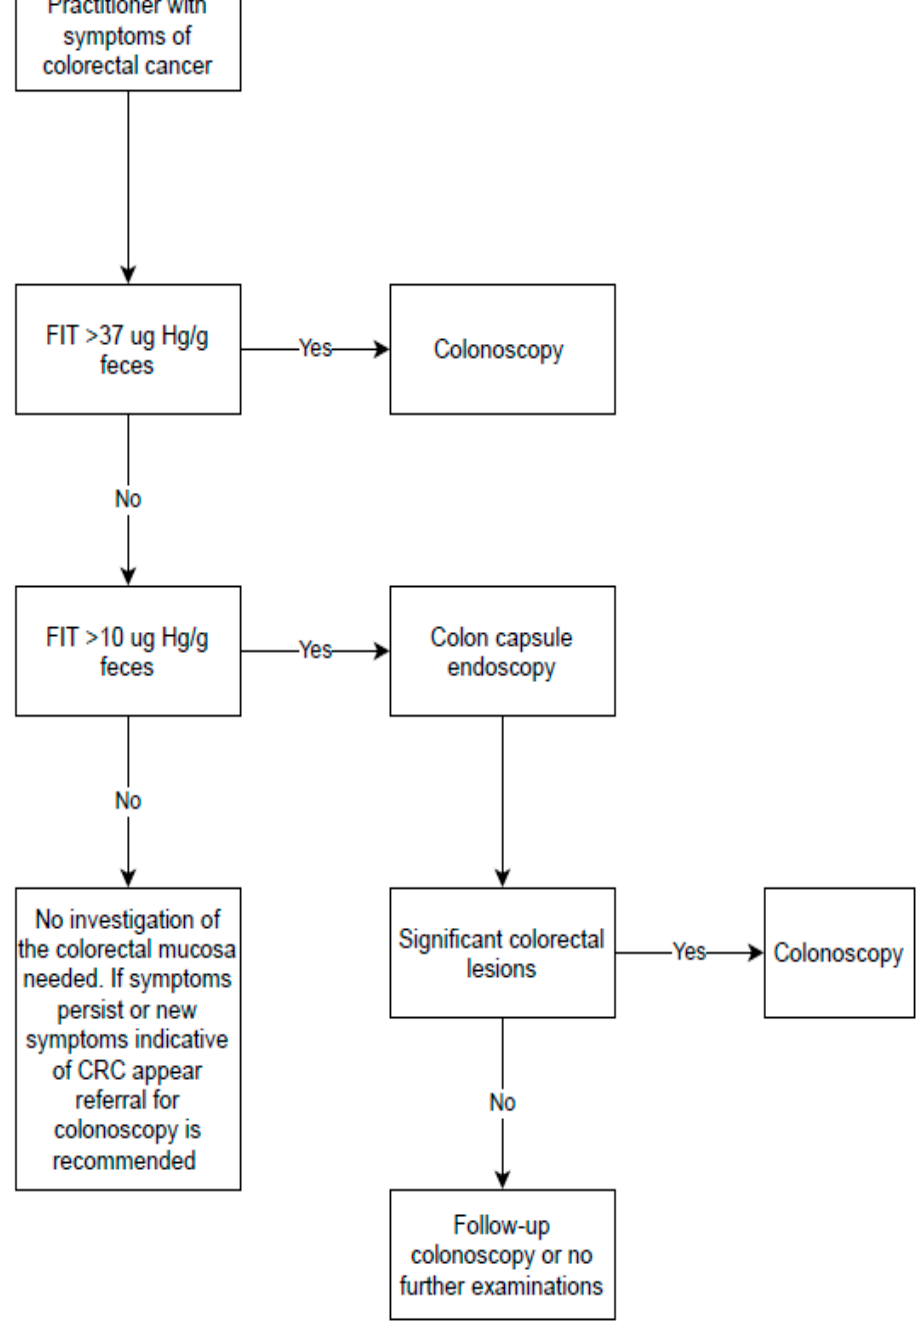
Figure 1. Suggested flow of patients presenting with symptoms of colorectal cancer at their general practitioner. Definitions: significant colorectal lesions: suspected cancer or any polyps > 9 mm.